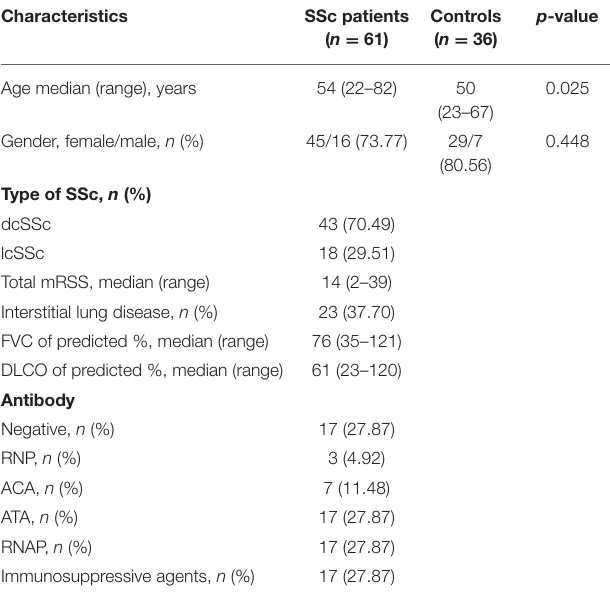
TABLE 2 | Demographic and clinical characteristics of subjects at skin biopsy.